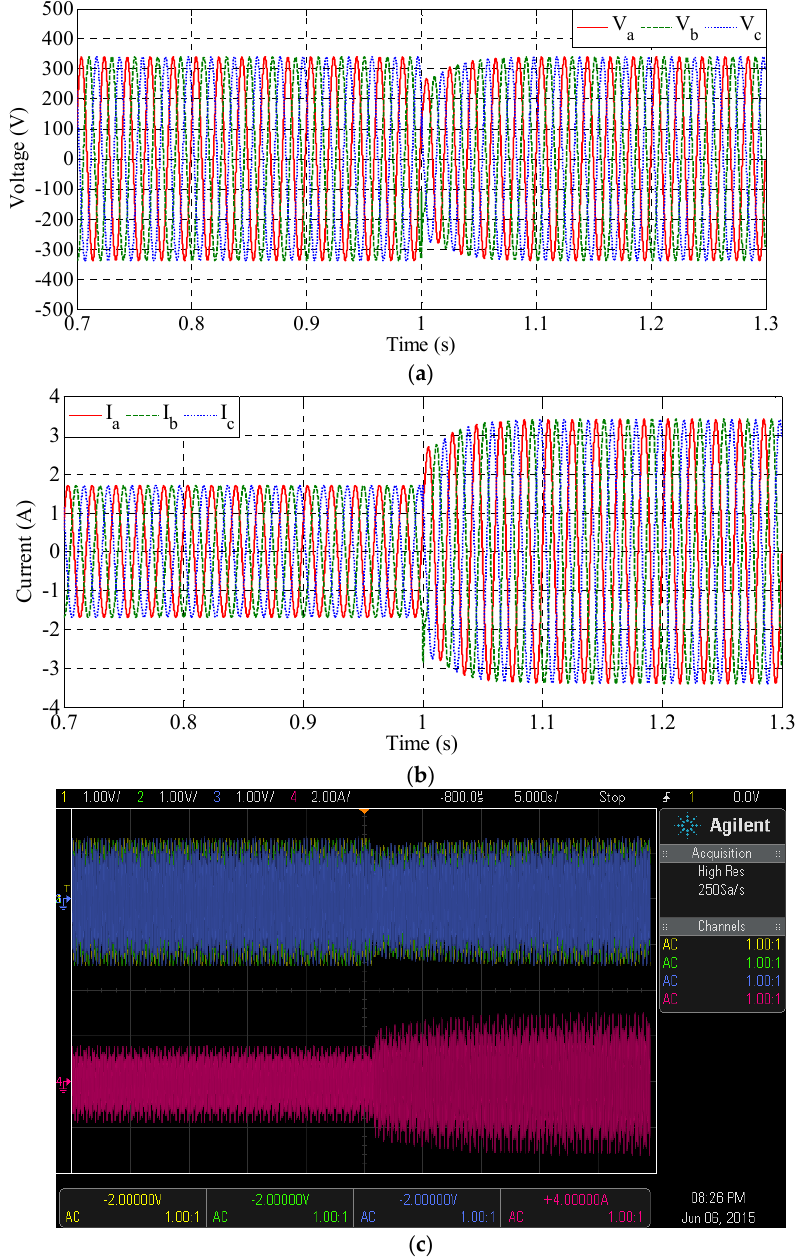
Figure 19. Output waveforms with R load increasing from 750 W to 1500 W. ( a ) Simulation voltage waveforms; ( b ) simulation current waveforms; and ( c ) experimental voltage and current waveforms (Ch. 1, Ch. 2, Ch. 3, and Ch. 4 for V a , V b , V c , and I a ,